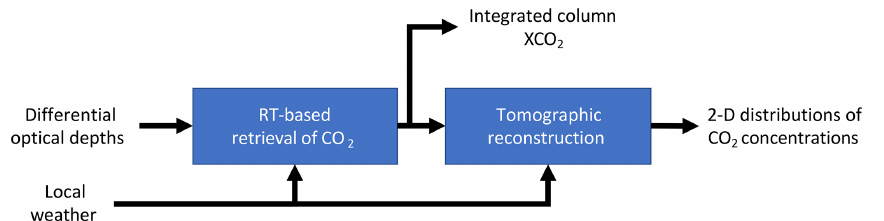
Figure 3. Block diagram of the GreenLITE ™ remote data processing stream from differential optical depths to 2-D distributions of CO 2